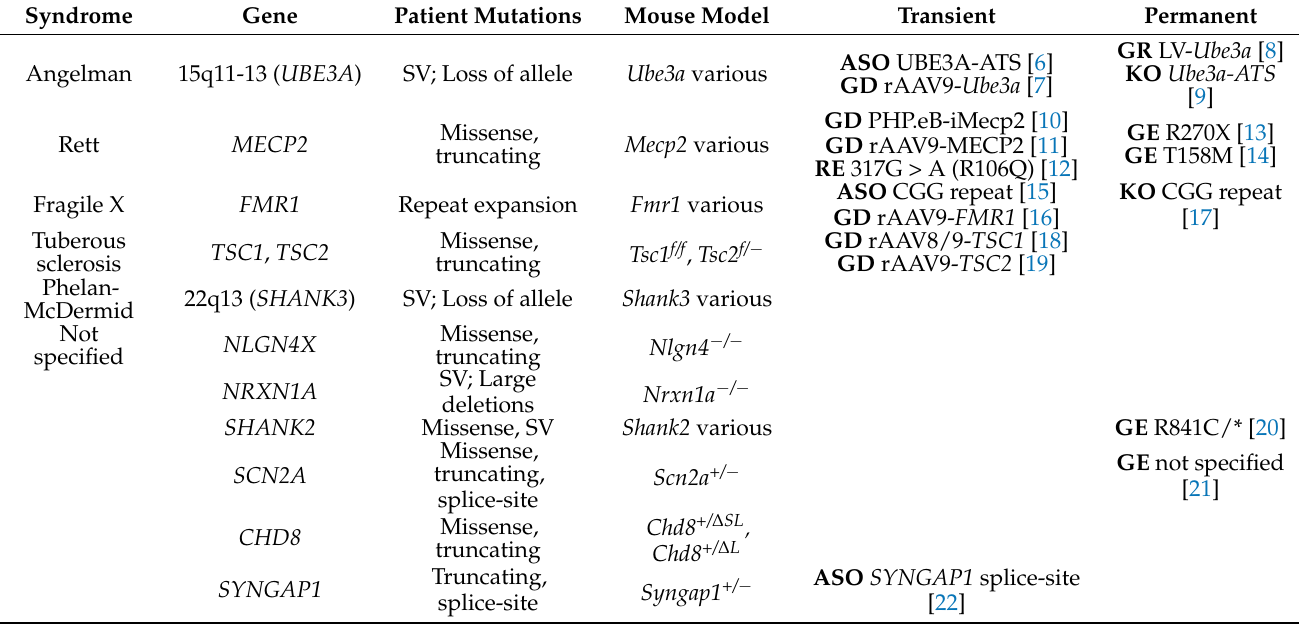
Figure 1. Gene therapies for syndromic autism spectrum disorders. Left; transient gene therapies such as antisense oligonucleotides (ASO), noncodingRNA (ncRNA), RNA editing and gene delivery. Right; Permanent gene therapies inlcude those that edit the host cell genome such as gene replacement (aimed at integration in the genome), CRISPR-KO (for targeted genomic disruptions) and Gene editing (for targeted repair of disease-causing mutations). Red and blue nucleotides display synthetic RNA or DNA, respectively. Green nucleotides display host-cell endogenous RNA or DNA. Created with BioRender.com. Table 1. Monogenic Syndromic ASD Covered in this